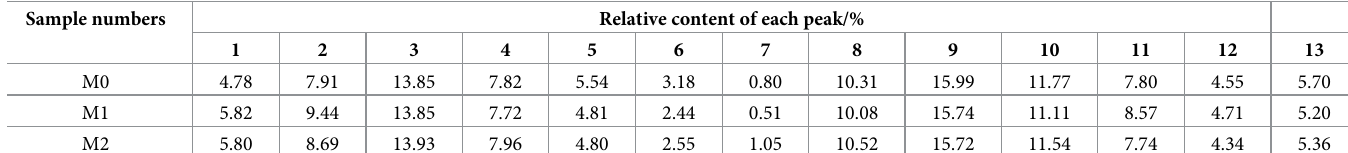
Table 8. Fitting results of NMR of